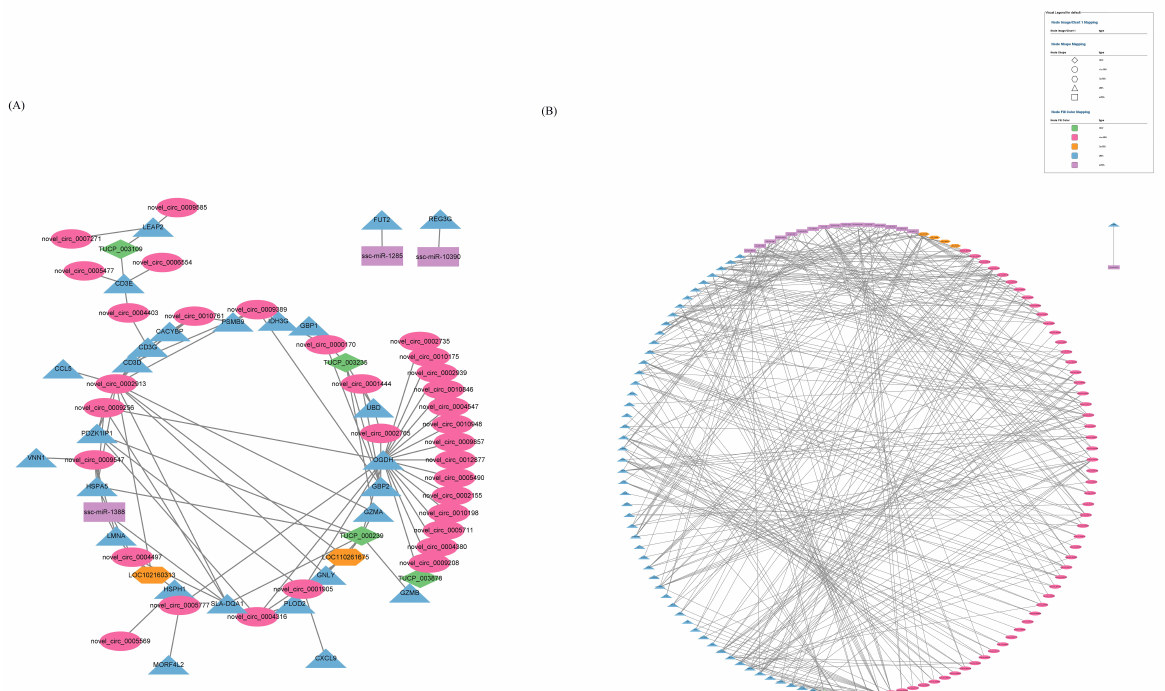
Figure 10. Combined analysis of mRNAs, miRNAs, lncRNAs, TUCP, and cicrRNAs. ( A ) The network of I–V set. ( B ) The network of P